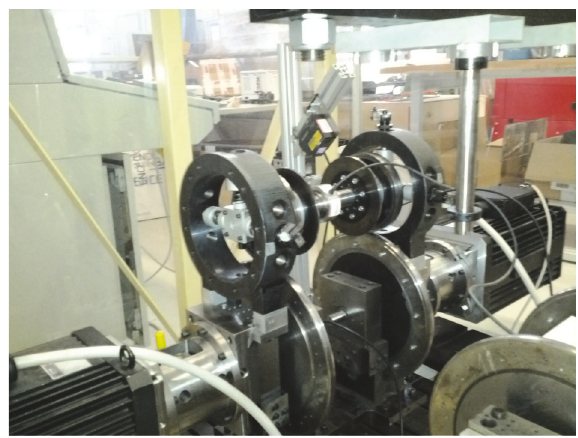
Figure 1: Roller-rig with a single suspended wheelset.